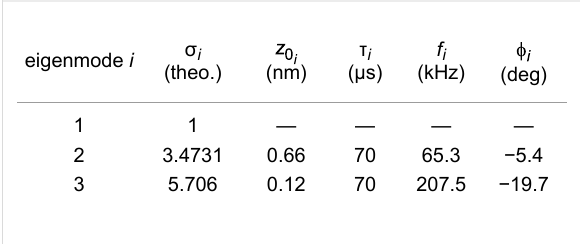
Table 2: Optical sensibilities σ i and the damped harmonic oscillator parameters used for the reconstruction of the tip trajectory [5].